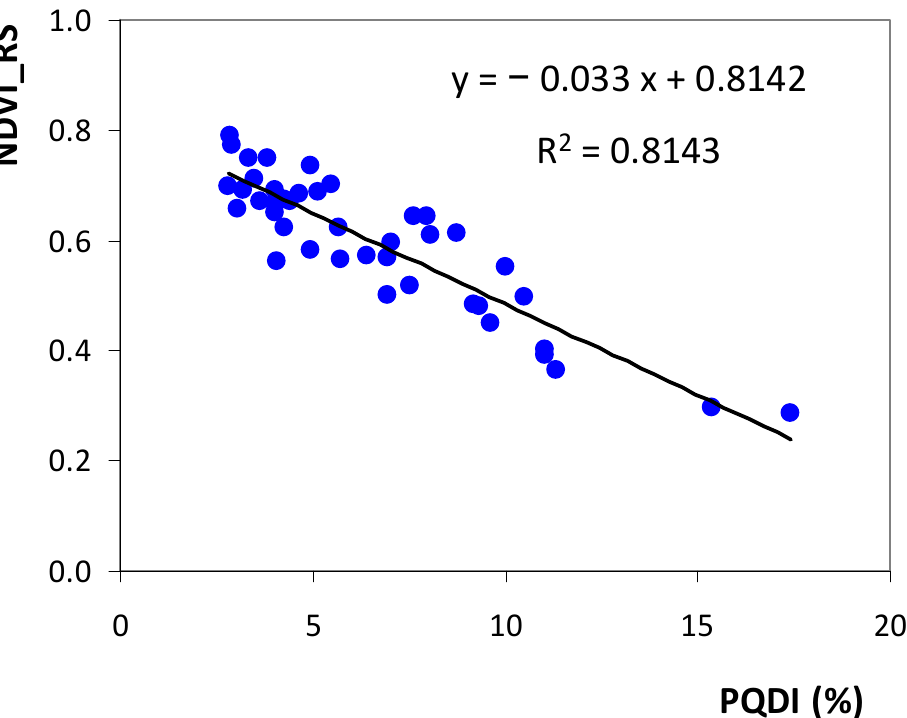
Figure 21. Regression analysis between NDVI obtained by remote sensing (NDVI RS ) and Pasture Quality Degradation Index (PQDI).